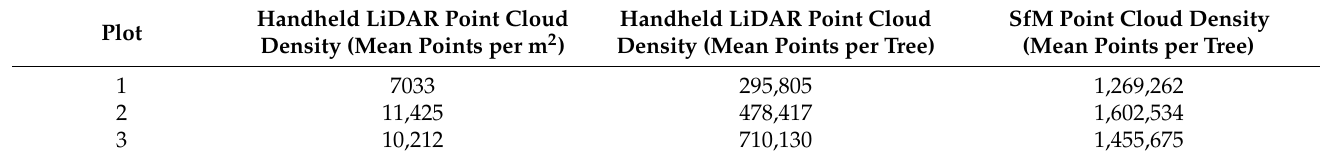
Table 4. Mean point cloud density from handheld LiDAR and Structure from Motion (SfM) pho- togrammetry of three, 400 m 2 fixed-radius forest inventory plots.